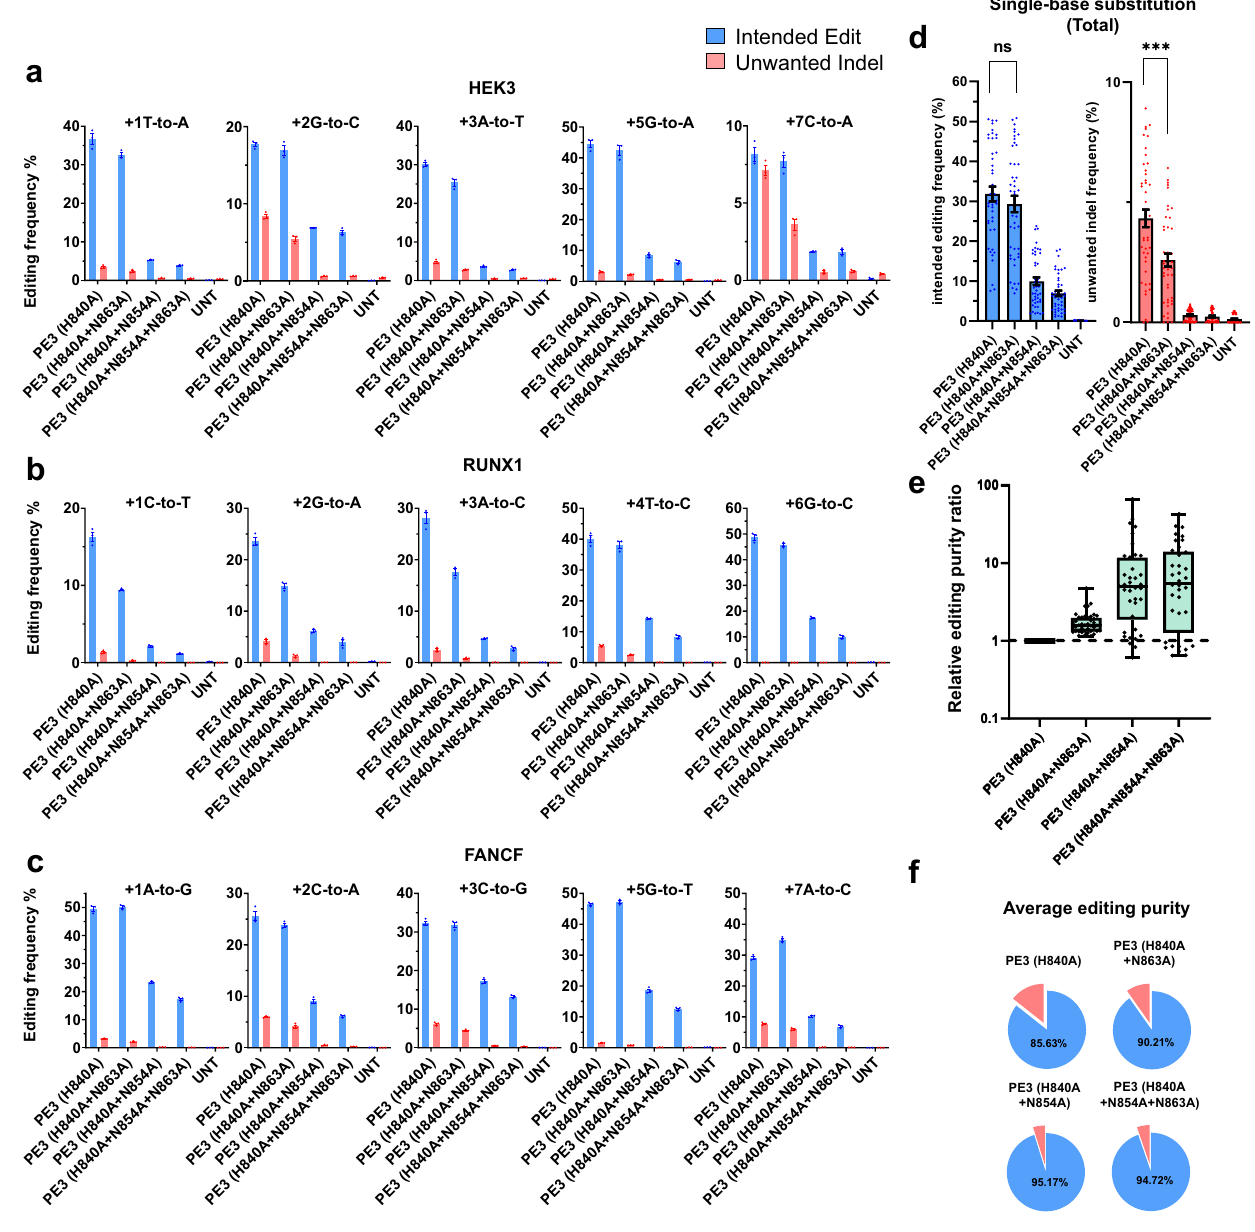
Fig. 4 | PE variants that incorporate improved nCas9 variants, used in the PE3 system, induce fewer unwanted indels. a – c Plasmids encoding PE (nCas9 variants), individual pegRNAs encoding fi ve different single-base substitutions targeted to three sites, and nicking sgRNAs were transfected into HEK293T cells. The frequencies of the correct edits and unwanted indels at the HEK3 ( a ), RUNX1 ( b ),and FANCF ( c )sites.Theintendedbasesubstitutionsareindicatedatthetopof eachgraph. d Theaveragefrequenciesofthecorrecteditsandunwantedindelsfor the fi ve single-base substitutions at the HEK3 , RUNX1 , and FANCF sites. ns; p =0.355739, *** p =0.000237. e , f Relative editing purity ratios (the frequency of correct edits normalized to that induced by PE3 (H840A) / the frequency of